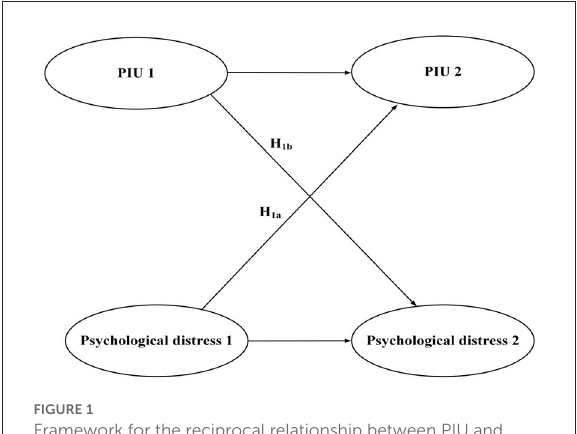
FIGURE1 Framework for the reciprocal relationship between PIU and psychological distress; variables include psychological distress and two forms of problematic internet use (PIU): problematic social media use and problematic gaming.